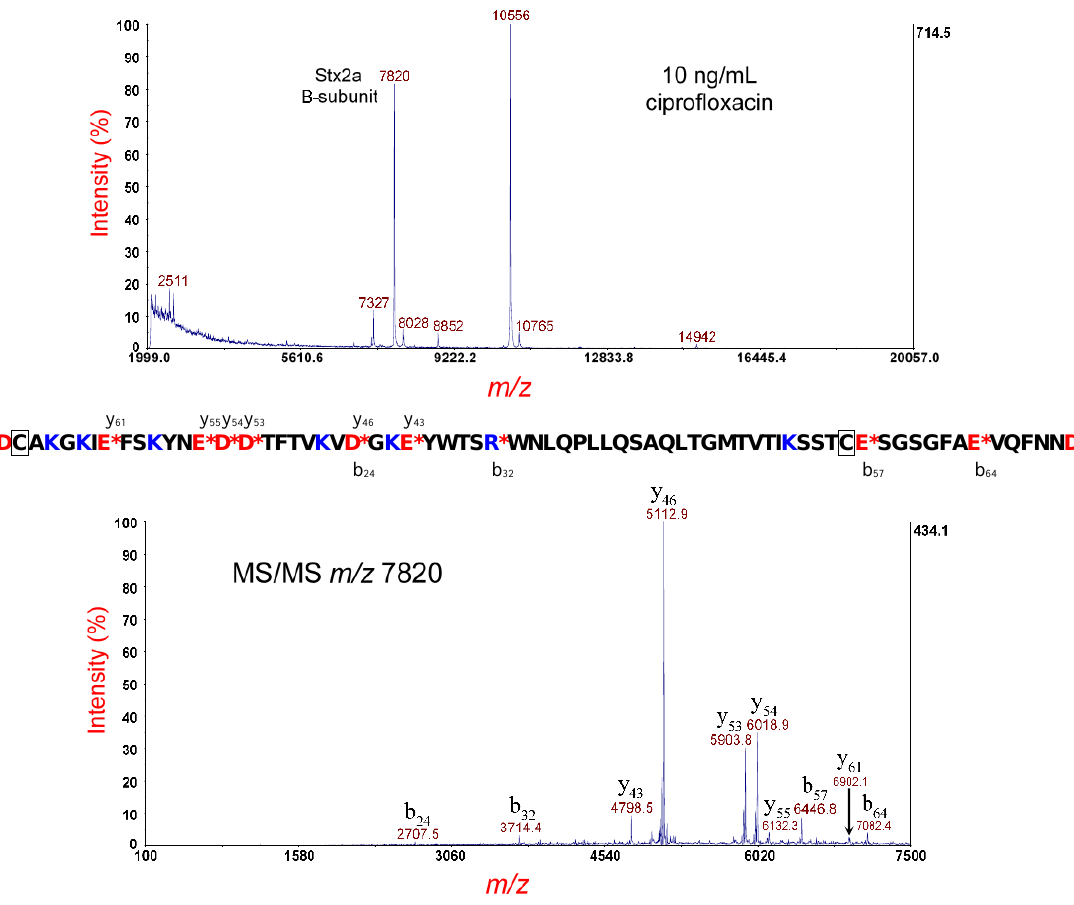
Figure 2. Top panel: MS analysis of E. coli O157:H- strain 493 / 89 cultured overnight on LBA supplemented with 10 ng / mL of ciprofloxacin. The sample supernatant was disulfide-reduced. The putative disulfide-reduced B-subunit of Stx2a is indicated. Bottom panel: MS / MS analysis of the putative B-subunit at m / z 7820 (top panel). Fragment ions are indicated by their m / z and b- or y-type designations. The sequence of the Stx2a B-subunit is shown. A red asterisk indicates sites of polypeptide backbone cleavage that generate the corresponding fragment ions shown above (y-type) or below (b-type) the sequence. Acidic residues are highlighted in red and basic residues in blue. Cysteine residues are boxed.